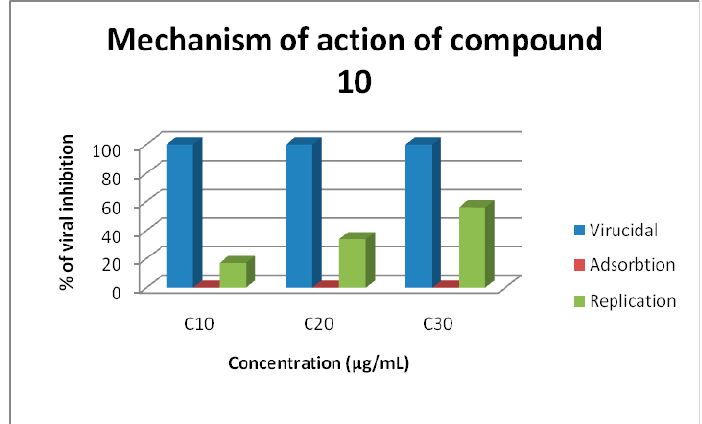
Figure 3. Virucidal effect on viral replication.